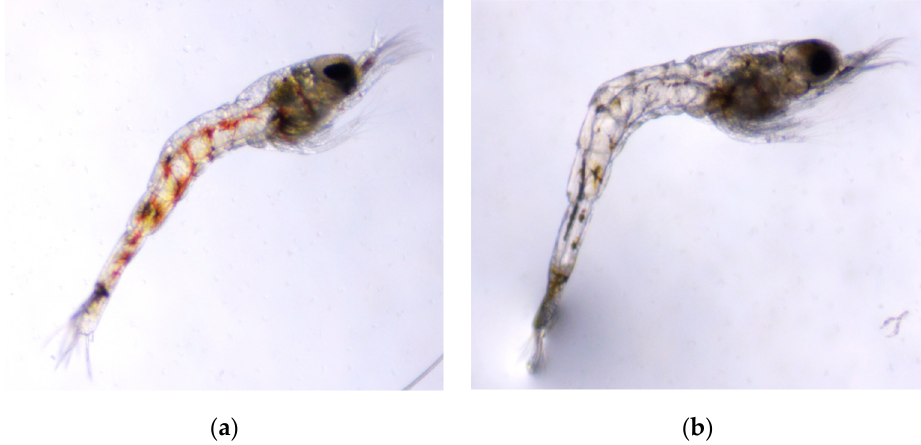
Figure 4. A. lanipes larva exposed to a suspension of TiO 2 NPs for 24 h showing changes in body pigmentation: ( a ) control A. lanipes larva, normal pigmentation along the abdomen; ( b ) A. lanipes larva exposed to 50 mg/L of TiO 2 NPs, loss of pigmentation as a result of exposure to TiO 2 NPs. The images were obtained using a stereo microscope (3.5 × -90 × LED Trinocular Zoom + 14 MP USB 3.0 Digital Camera). Both larvae were in the zoea I larval stage; the total length of the larvae is 1.3 mm. In contrast, we found an edema in the abdominal area of the larvae during the 72 h exposure to the TiO 2 NPs concentration of 150.0 mg/L (Figure 5). We did not find another case of edema in another period of exposure or concentration of TiO 2 NPs .